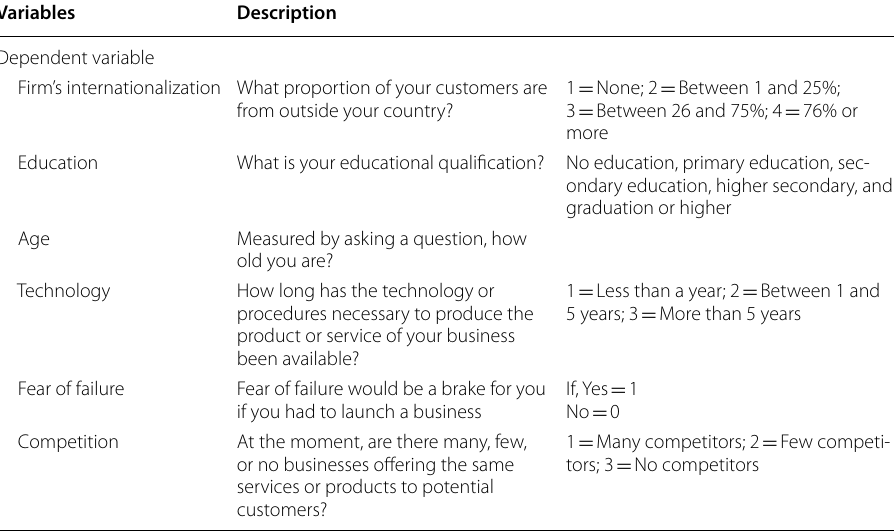
Table 1 Description of variables (as per GEM) Variables Description